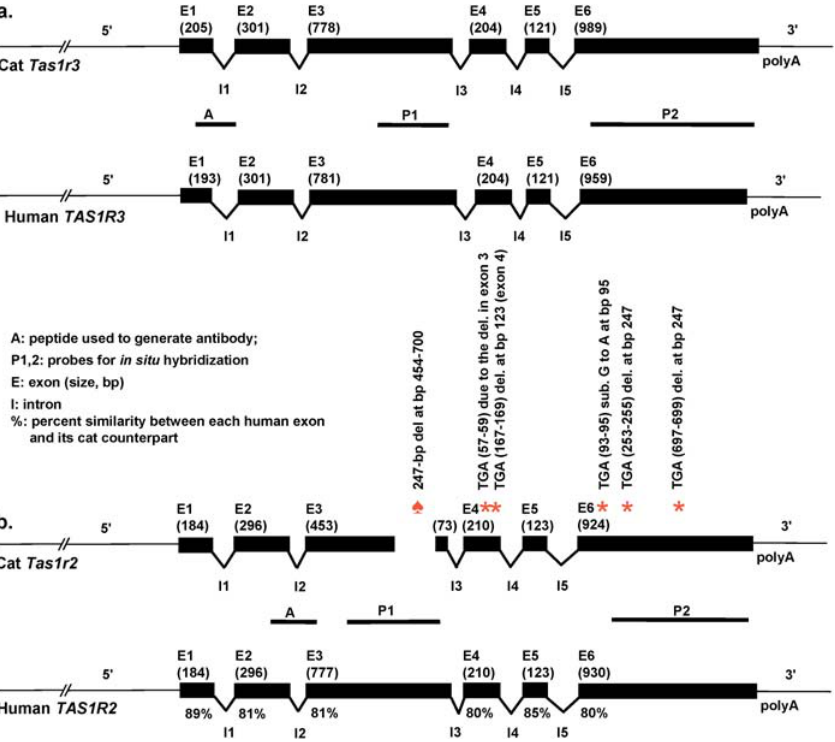
Figure 2. Gene Structures of Cat Tas1r3, Human TAS1R3 , and Cat Tas1r2 , Human TAS1R2 The exons are shown in black (size in bp of each exon is in parentheses). Boundaries of gene sequences used to produce probes for in situ hybridization studies (Figure 3) are shown by the horizontal lines labeled ‘‘ P1 ’’ and ‘‘ P2 ’’ under the sketch of the cat Tas1r3 and cat Tas1r2 . Boundaries of sequence used to generate peptide antigens for immunohistochemical studies (Figure 4) are shown by the horizontal lines labeled ‘‘ A ’’ under the sketch of the cat Tas1r3 and cat Tas1r2. The locations referred to in the vertical explanation text above the asterisks and the spade symbol indicate the position in bp within each exon. Intron sizes shown in the figure are not proportionally scaled on both (A) and (B) because of the large size of Tas1r2 introns. Under each human exon is the percent similarity between each human exon and its cat counterpart at the nucleotide level (Figure 2B). The exons for cat Tas1r2 refer to parts corresponding to human exons. The spade symbol ( ; ) indicates the position of microdeletion in exon 3 of cat Tas1r2 . Asterisks ( * ) indicate the stop codon positions in exon 4 and 6 of cat Tas1r2 . Note that nucleotide numbers of the exon 3 in human TAS1R2 and cat Tas1r2 are not identical. DOI: